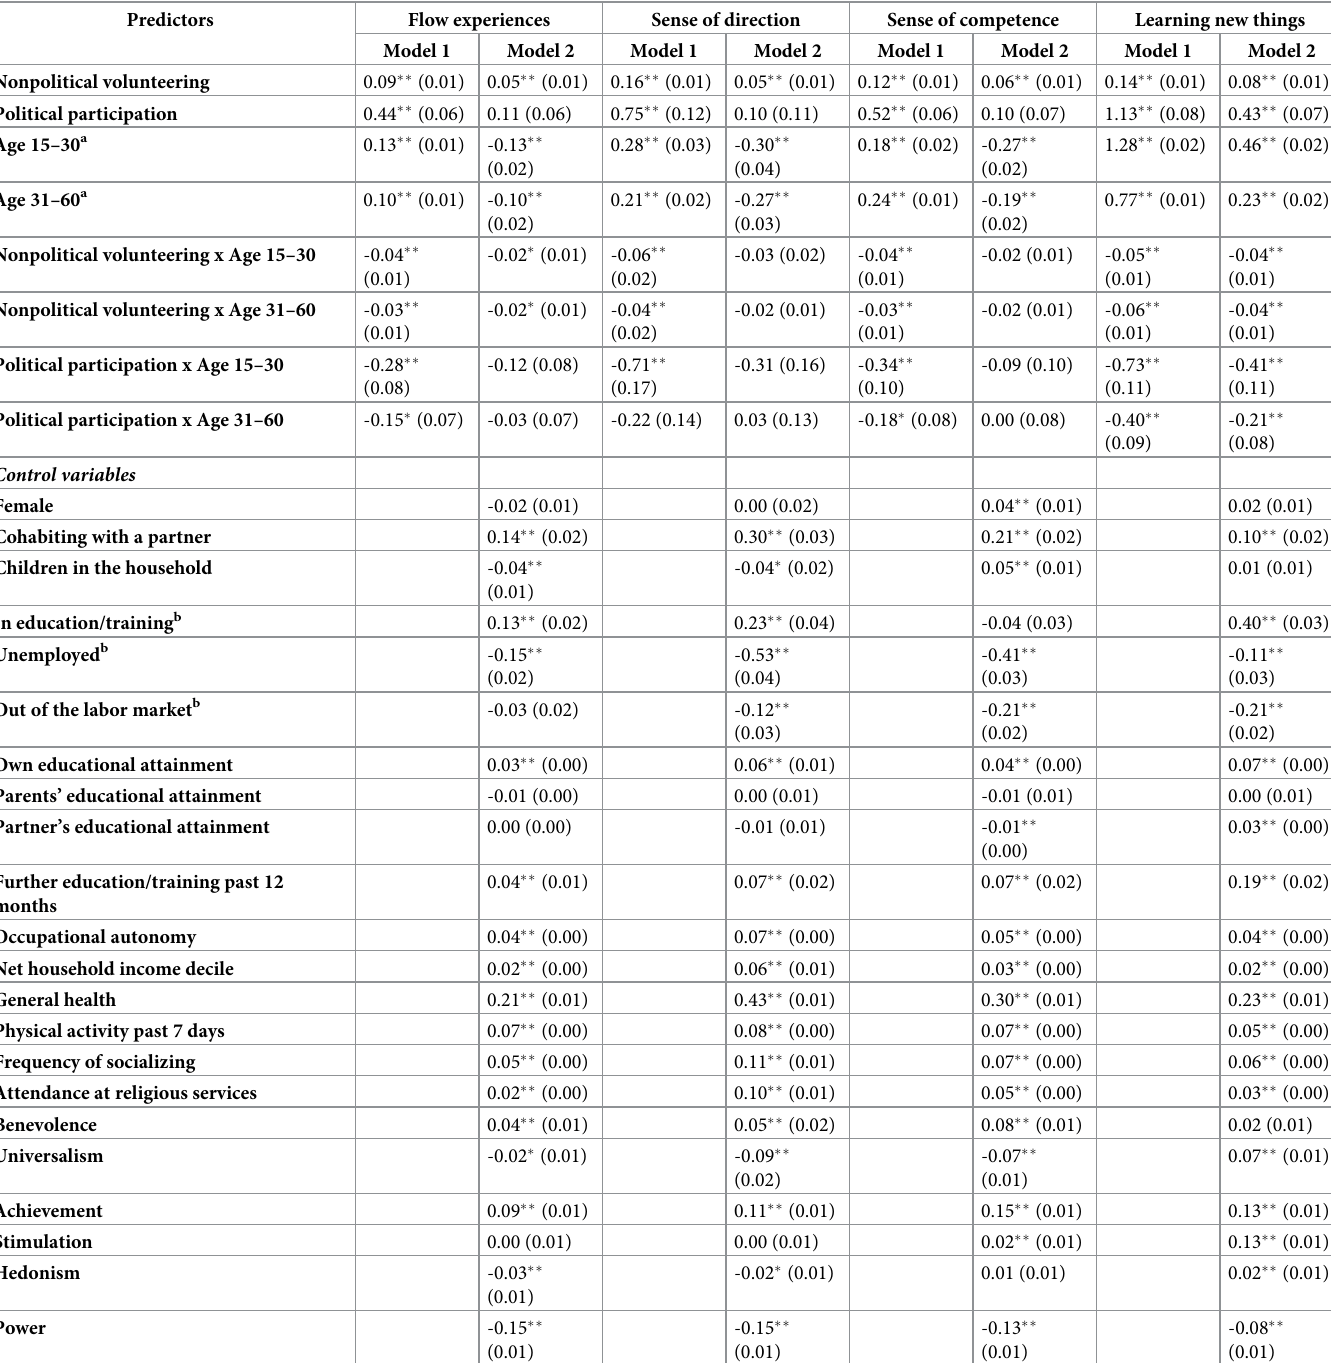
Table 4. Individual-level effects of nonpolitical volunteering and political participation on eudaimonic